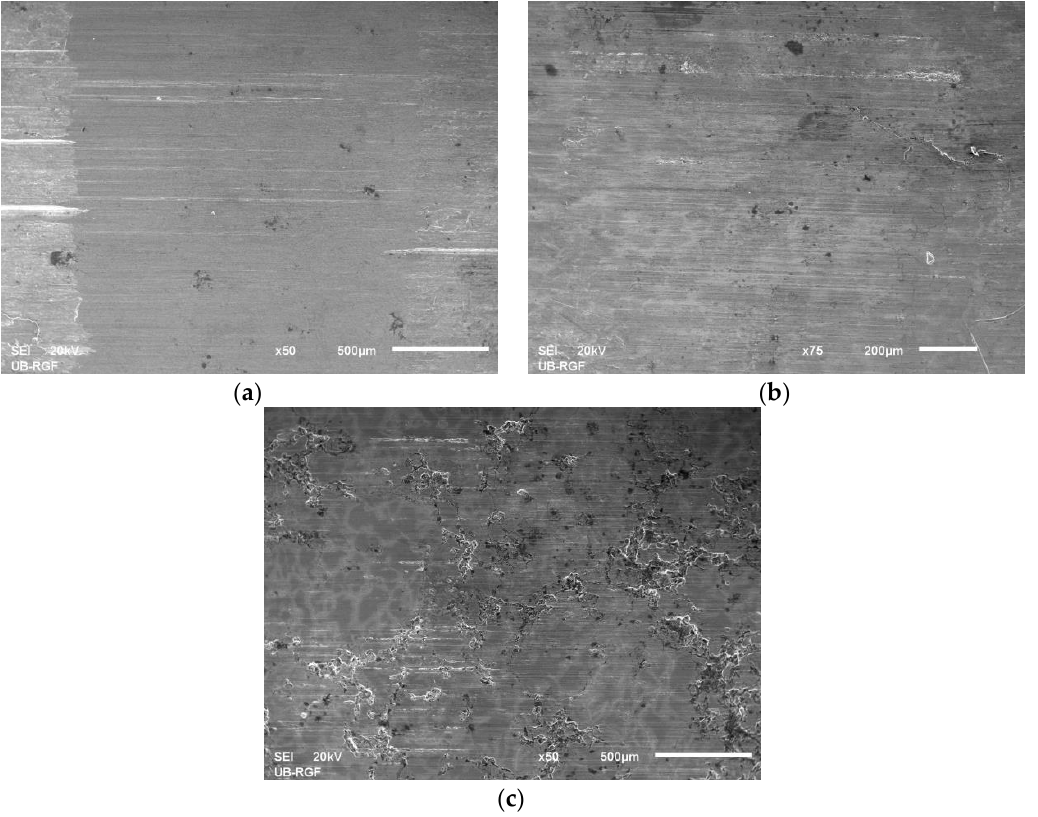
Figure 8. Worn surfaces of the tested materials taken by scanning electronic microscope (SEM) for 120 N of normal load and 0.25 m/s of sliding speed: ( a ) ZA27; ( b ) ZA27/5%SiC; ( c ) ZA27/5% SiC/5%Gr.